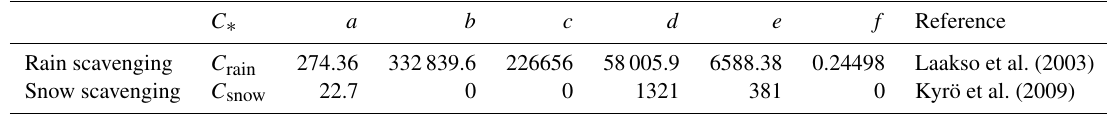
Table 2. Parameters used in Eq. (6) for below-cloud scavenging. C